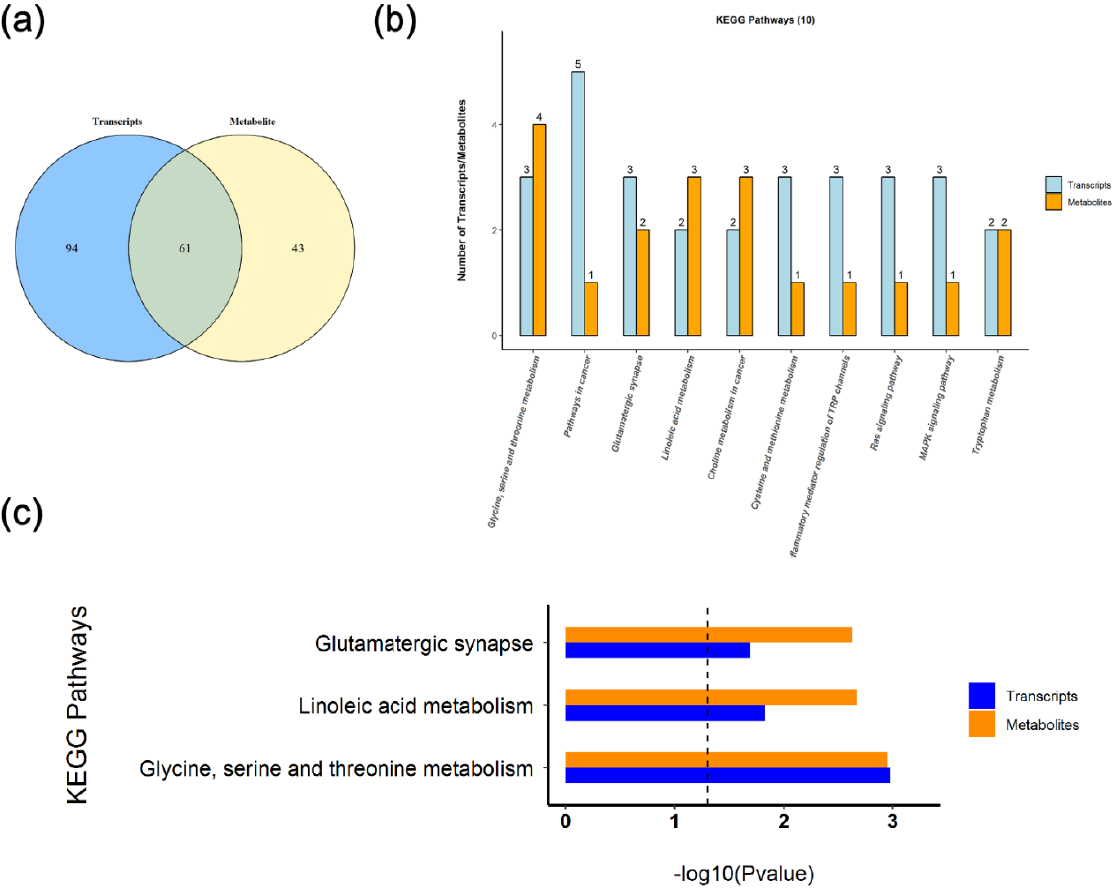
Figure 5. KEGG pathway joint analysis. ( a ) Venn diagram of the number of pathways involved in differential genes and differential metabolites. ( b ) KEGG pathways with the most involved genes and metabolites (top 10). ( c ) Significantly changed co-enriched KEGG pathways.